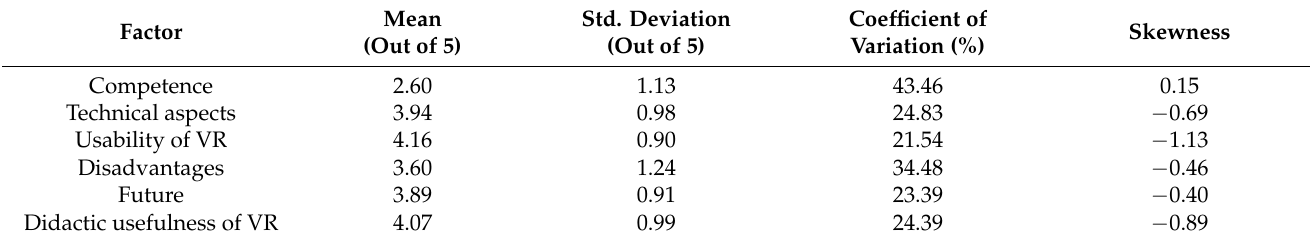
Table 2. Descriptive statistics of the responses (270 participants).